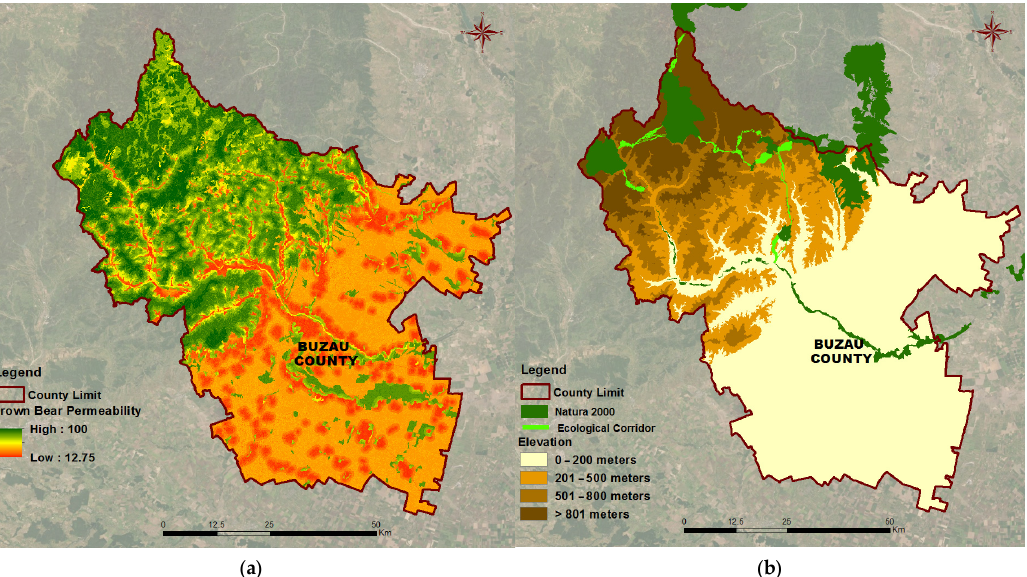
Figure 9. ( a ) Habitat permeability map of brown bear (Buz ă u County). The map indicates a higher permeability in the northern part of the county, unlike the southern part of the territory, having many barriers that lower the permeability; ( b ) The potential ecological corridors for the brown bear (in light green) obtained by applying the methodology. The map shows that they connect the Natura 2000 sites from the county and, according to the elevation, the potential ecological corridors are located between 500 and 1737 m (map created by the authors).